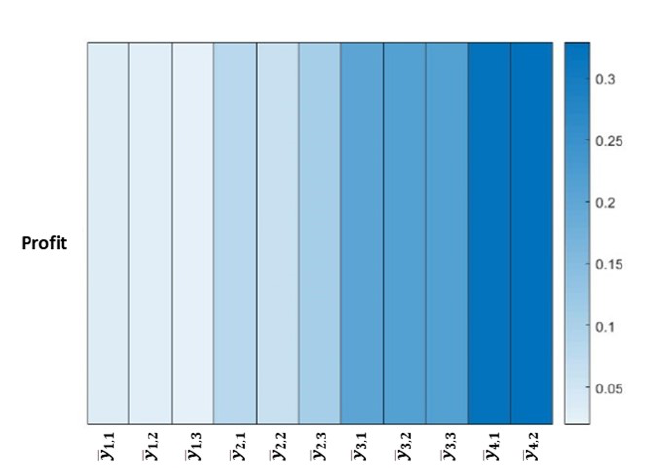
Figure 11. Sensitivity of the order amounts for the